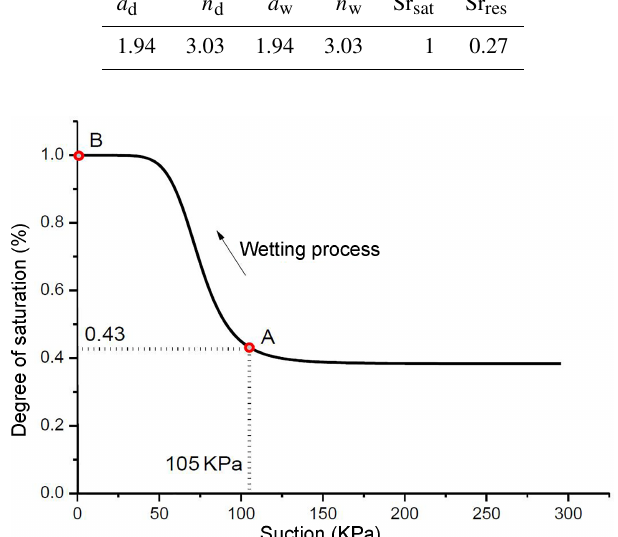
Figure 11. Relationship between suction and the degree of satu- ration during the monotonous wetting process. The segment from point A to point B shows the two mica-quartz schist.